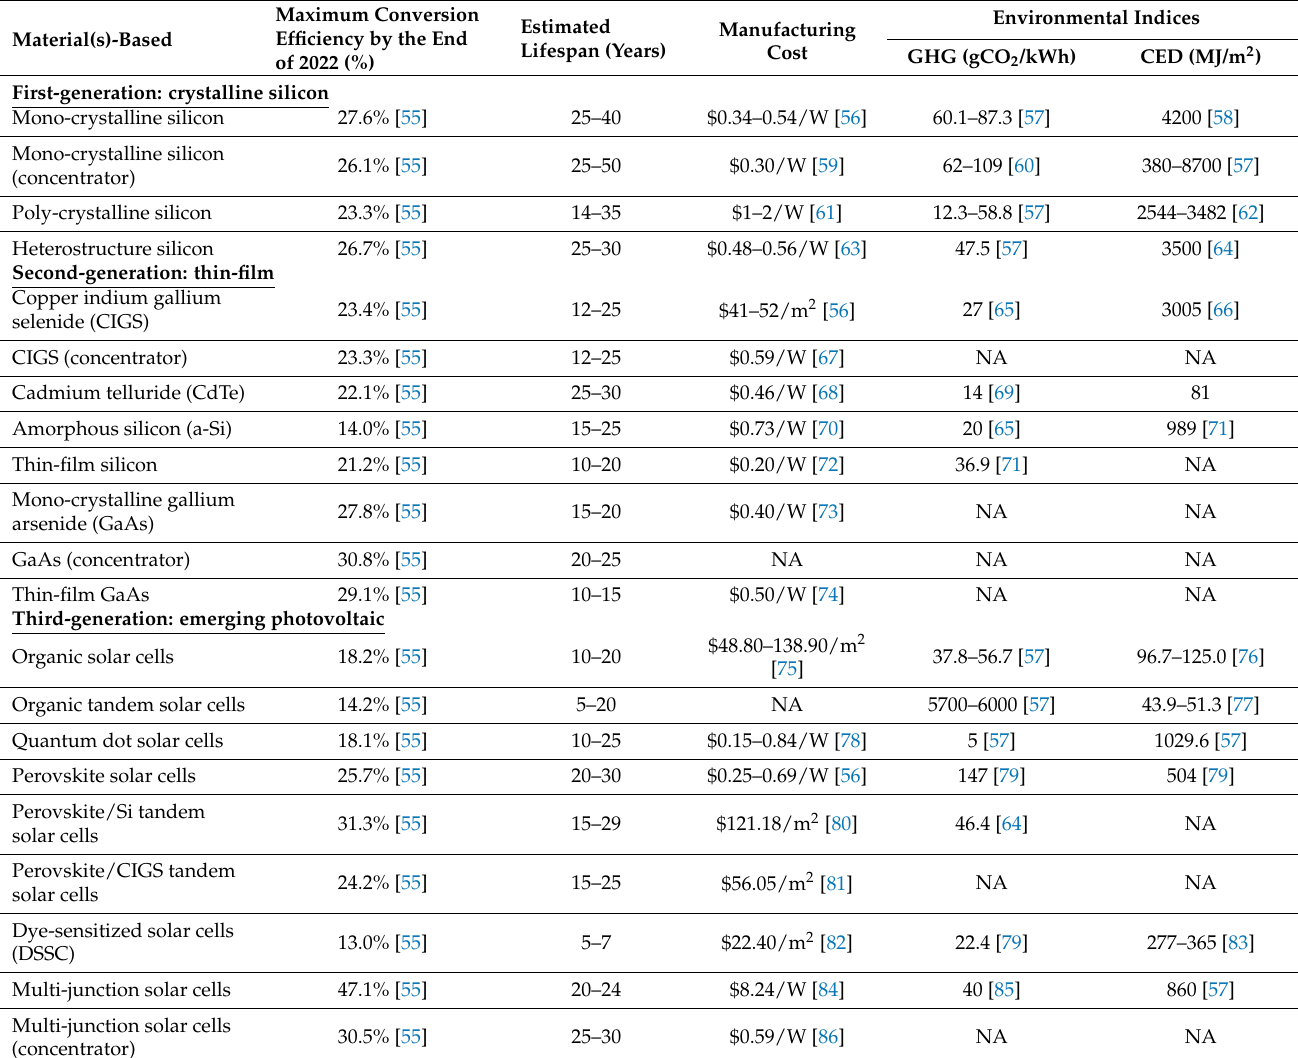
Table 4. Summary of efficiency, lifetime, cost and life cycle assessment of solar cells under the generation